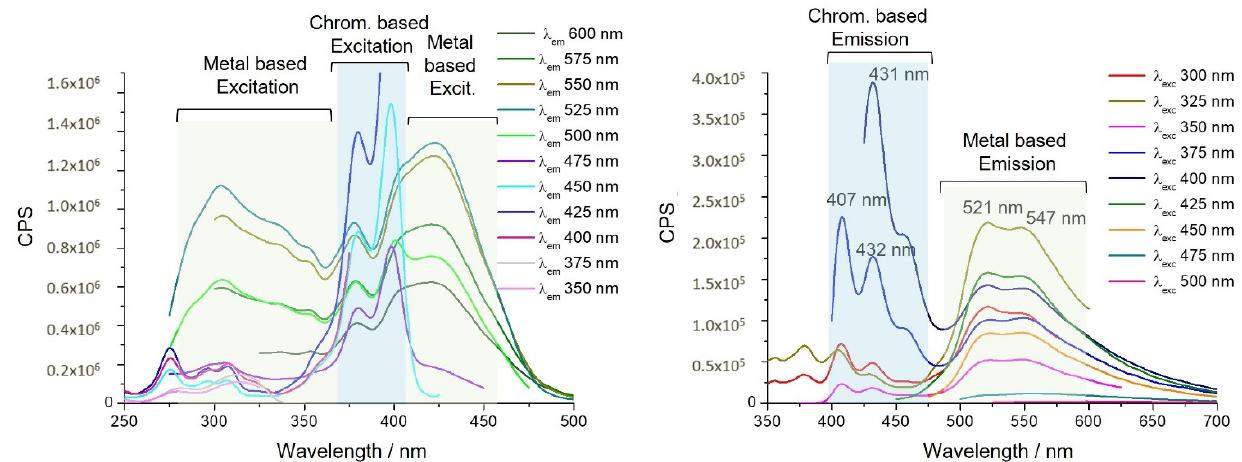
Figure 4. Excitation spectra ( left ) of complex 4 for the different emission profiles and the correspondent emission spectra ( right ) upon excitation at different wavelengths.